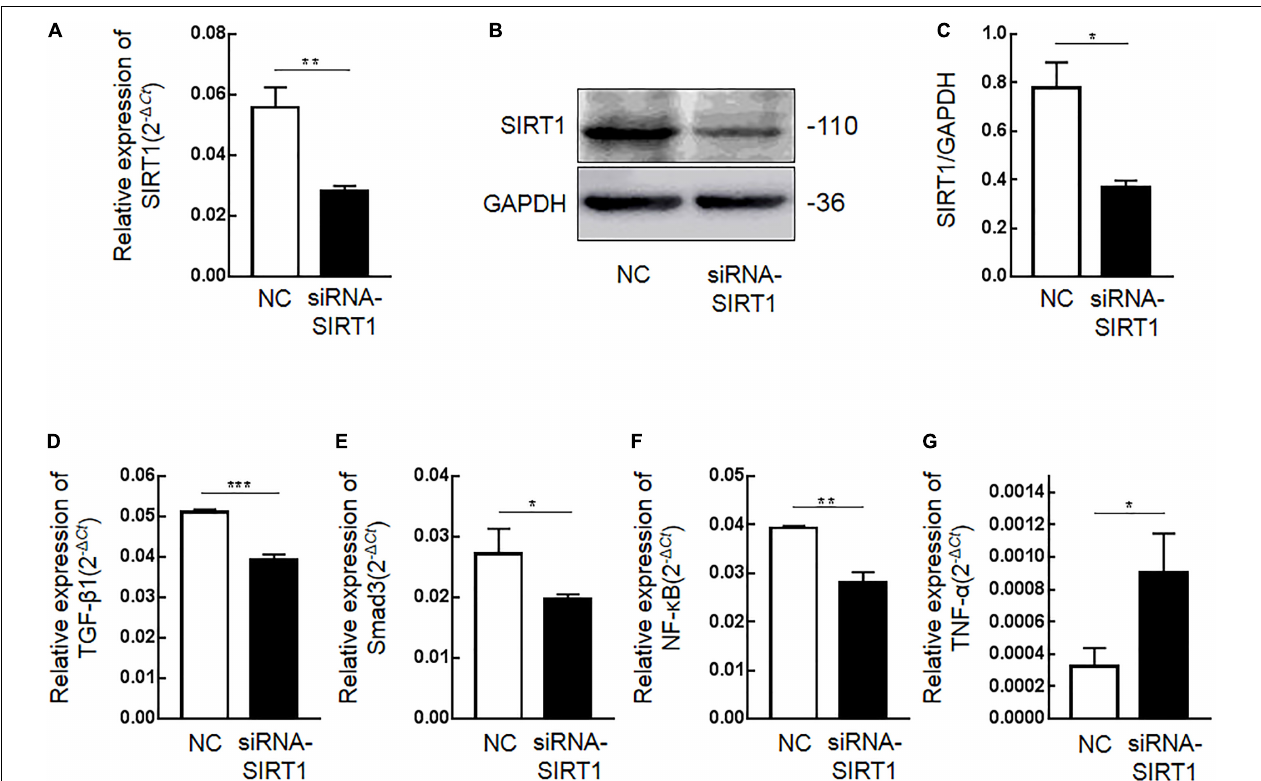
FIGURE 4 | The effect of Sirtuin1 or Silent mating–type information regulation 2 homolog-1 (SIRT1) on the mRNA expression of fibrosis-related factors in intestinal epithelial cells 6 (IEC6). (A) After transfection of siRNA-SIRT1, the mRNA expression of SIRT1 decreased. (B,C) After transfection of siRNA-SIRT1, the protein expression of SIRT1 decreased. (D) After inhibiting the expression of SIRT1 in IEC6 cells, the mRNA expression of transforming growth factor- β 1 (TGF- β 1) decreased. (E) After inhibiting the expression of SIRT1 in IEC6 cells, the mRNA expression of Smad3 decreased. (F) After inhibiting the expression of SIRT1 in IEC6 cells, the mRNA expression of NF- κ B p65 decreased. (G) After inhibiting the expression of SIRT1 in IEC6 cells, the expression of tumor necrosis factor- α (TNF- α ) mRNA in the cells increased. (*Denotes the siRNA-SIRT1 groups compared with the NC groups p < 0.05, ** denotes p < 0.01, *** denotes p < 0.001, n =